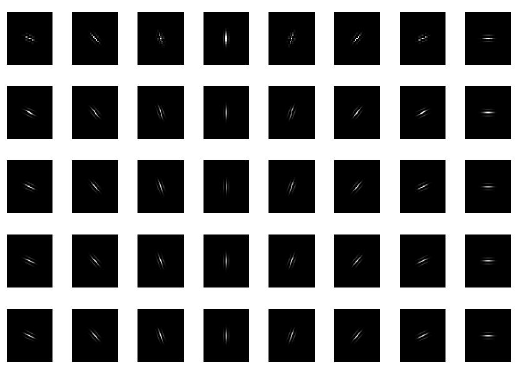
Figure 3. Gabor filter banks with different orientations and window widths.